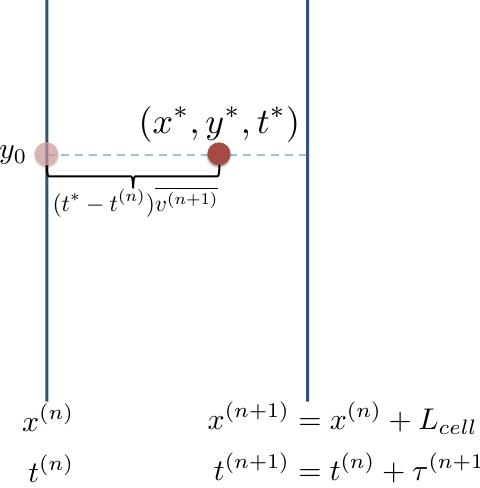
Figure 8. Illustration of the downscaling procedure Method 1 in the y direction. A particle is in Cell n + 1 and will travel through that cell over an amount of time τ ( n + 1 ) . The particle’s x location is determined using the method described in Section 4.1. We want to predict the particle’s y location at time t ∗ . In this method, the downscaled y location is equal to each particle’s initial y position, y 0